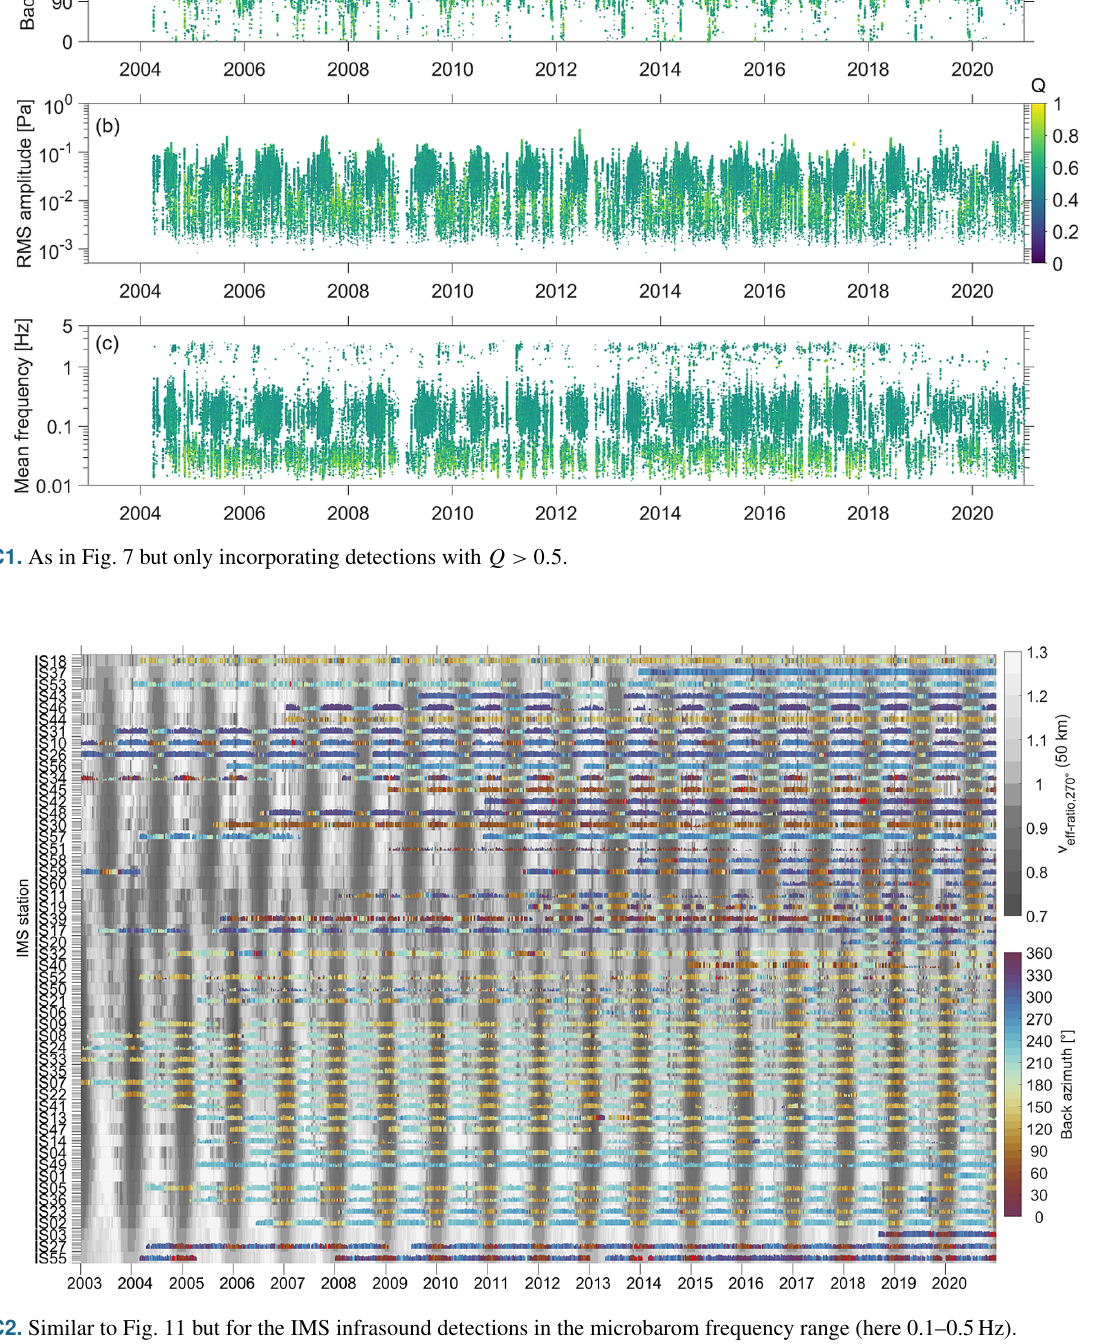
Earth Syst. Sci. Data, 14, 4201–4230,